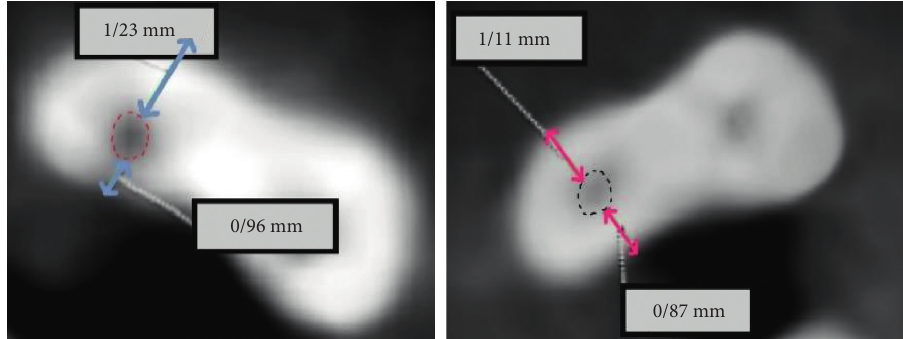
Figure 2: Image of a sample showing the location of X1, X2, Y1, and